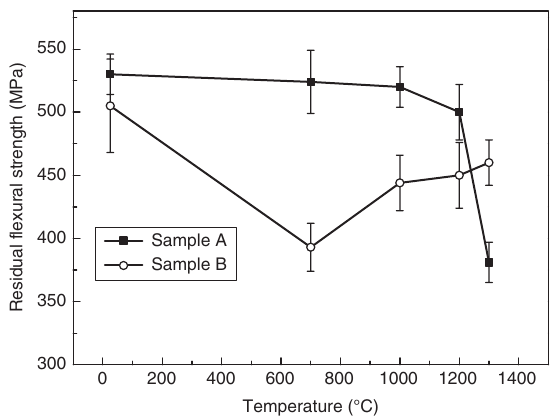
Figure 6 The residual flexural strength vs. the oxidation